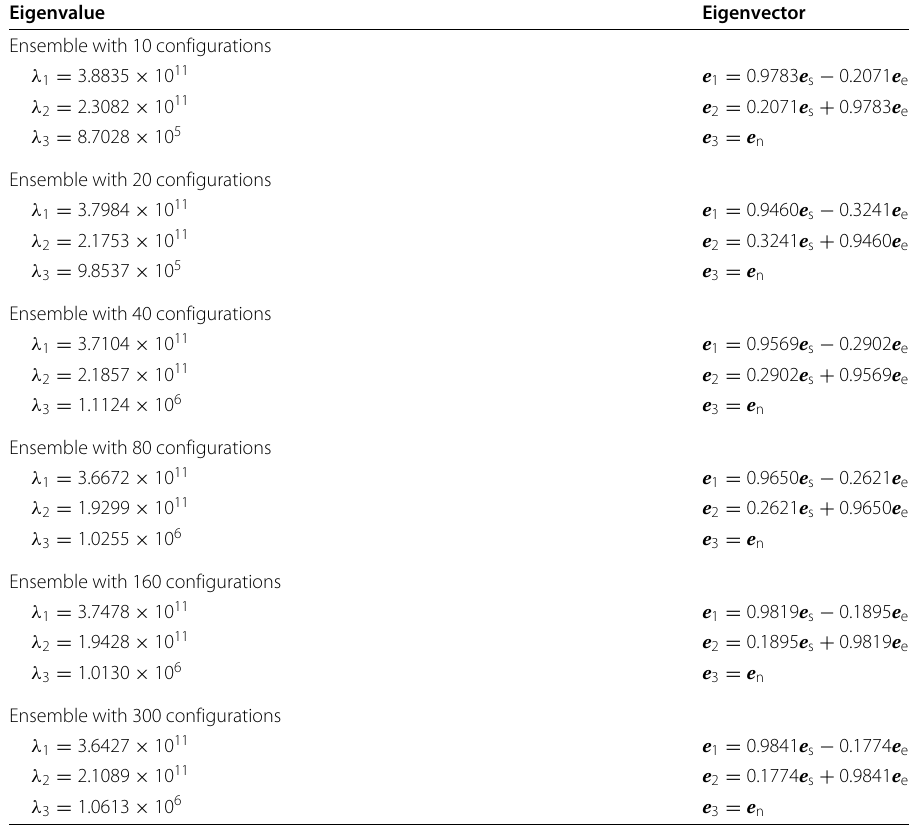
= 0.9783 e − 0.2071 e 1 s e = 0.2071 e + 0.9783 e 2 s e = e 3 n = 0.9460 e − 0.3241 e 1 s e e 2 = 0.3241 e s + 0.9460 e e e 3 = e n